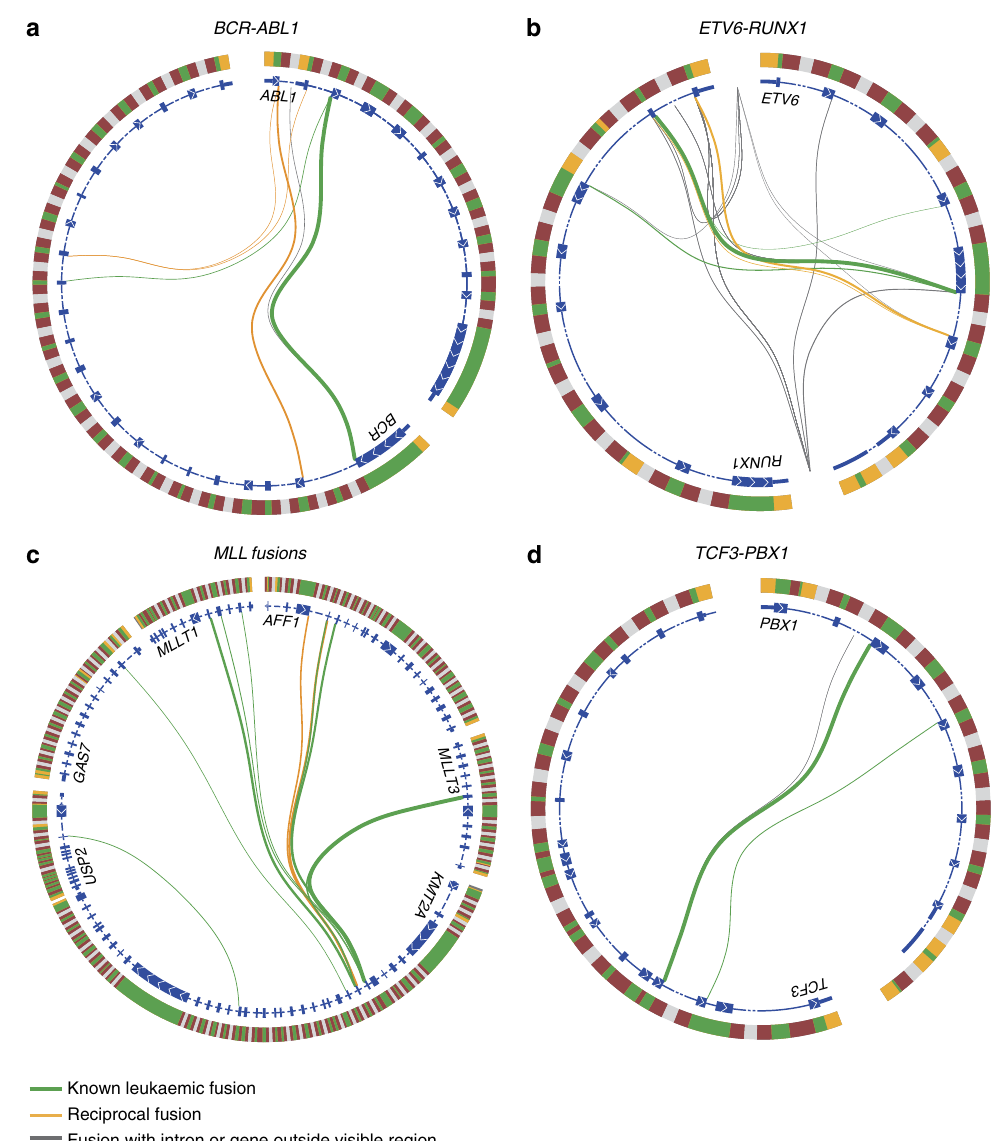
Figure 6 | Splice patterns over fusion breakpoints. Illustration of all detected fusion breakpoints in BCP ALL cases with ( a ) BCR-ABL1 , ( b ) ETV6-RUNX1 , ( c ) MLL fusions, and ( d ) TCF3-PBX1 . Genes are arranged clockwise by genomic position. The outer circle represents the genomic region encompassing the indicated genes. Yellow indicates untranslated regions, green indicates coding exons, and red and grey indicate intronic regions (the latter are not to scale). The inner circle represents one or two overlaid reference transcripts of the indicated gene. Coding exons are indicated by a thick line with white arrows indicating the direction of the gene, introns are indicated by a thin or dashed line and untranslated regions are indicated by a medium thick line. Connecting lines between transcripts illustrate fusion breakpoints detected by at least three (for BCR-ABL1 , ETV6-RUNX1 and MLL fusions) or ten reads (for TCF3-PBX1 ). Fusion breakpoints in individual BCP ALL cases are depicted in Supplementary Figs